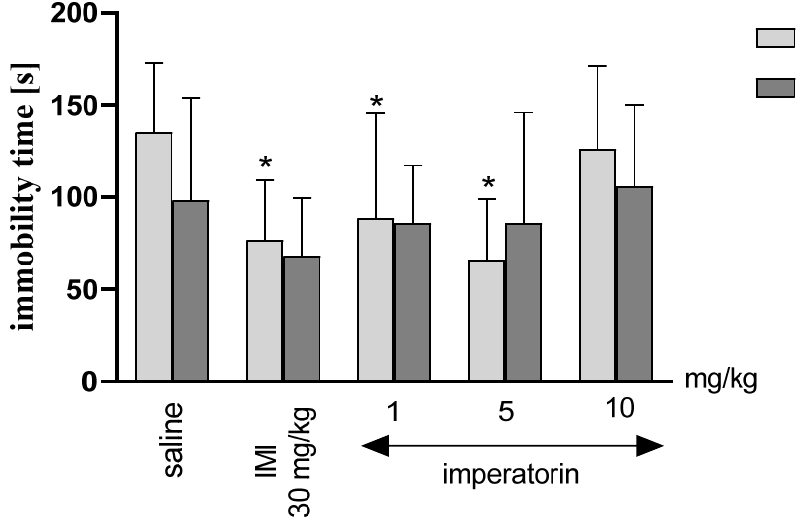
Figure 1. Duration of immobility in the FST in female mice. Saline, imipramine (IMI, 30 mg/kg), and imperatorin (1, 5, and 10 mg/kg) were injected ( i.p .) 30 min before the test and immobility time [s] was measured; n = 8–10; * p < 0.05; mean +/ − SD.